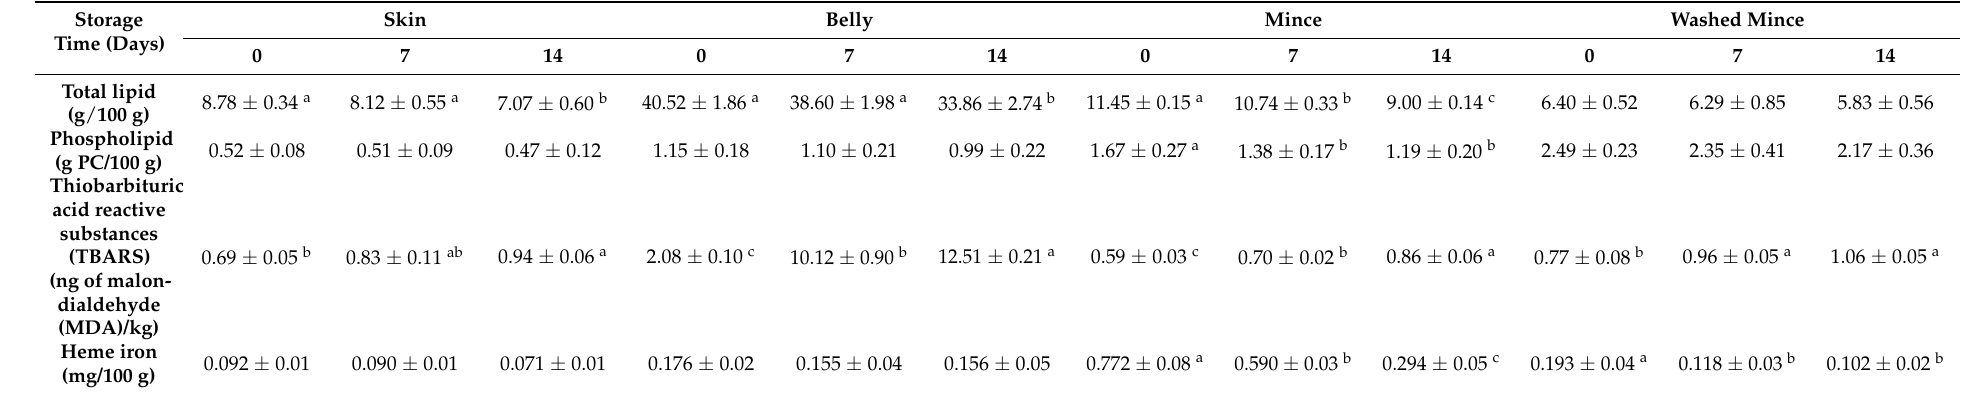
Table 1. Chemical composition changes of silver carp during iced storage for 14 days and their respective thrice-washed mince (dry